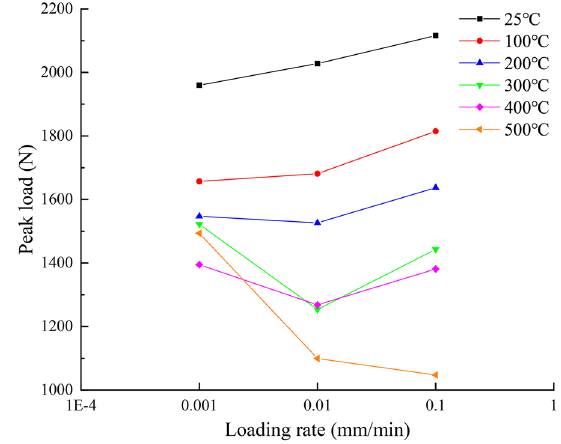
Fig. 5 Peak load versus loading rate at different